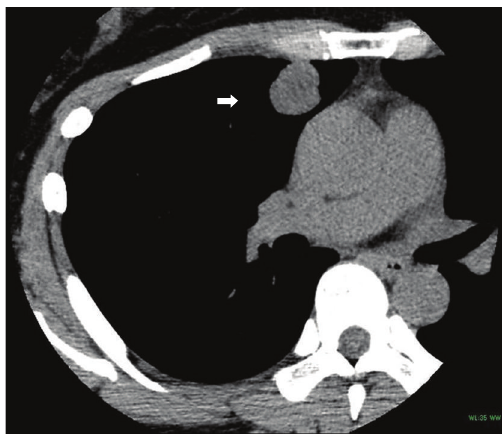
Figure 1: CT of the chest revealing a 2.0 × 2.0 cm nodular mass on the right peripheral upper lobe.